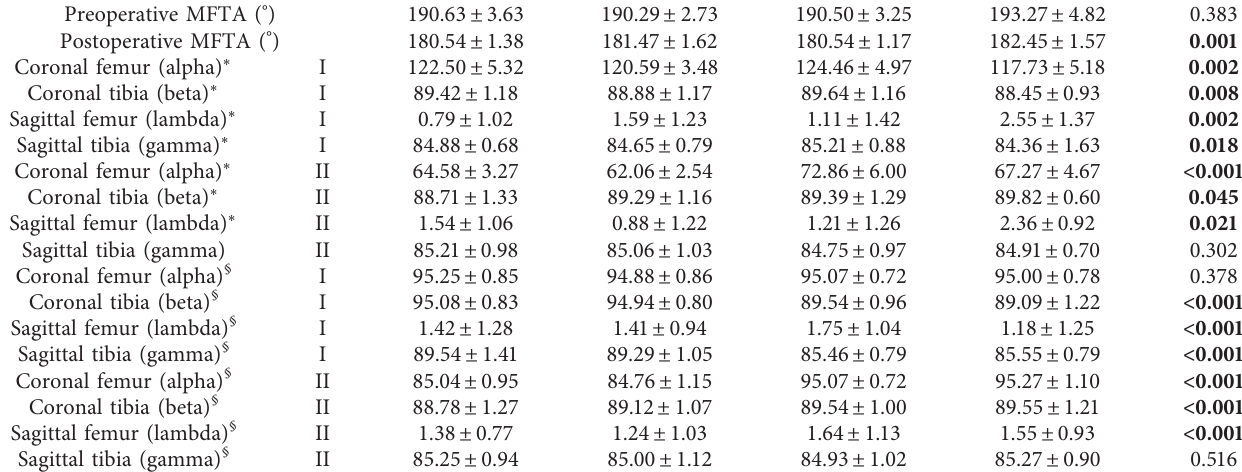
Table 3: Radiographic parameters before and after TKA.